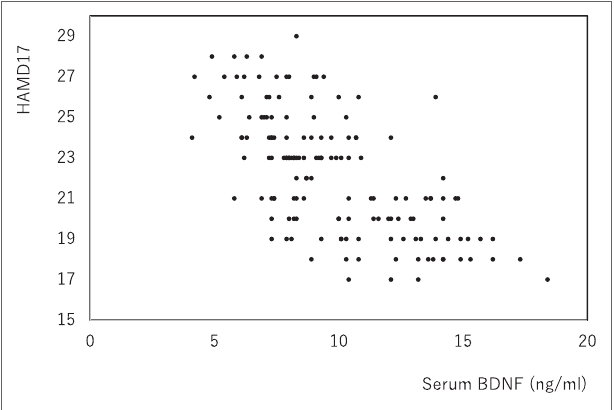
FigUre 1 | The changes in serum brain-derived neurotrophic factor (BDNF) and the HAMD17 scores. Data were analyzed by Pearson’s correlation coefficient ( r = − 0.654, p = 0.000).